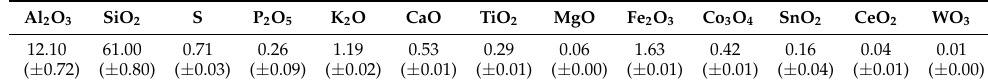
Table 1. Composition ( wt %) of diatomaceous